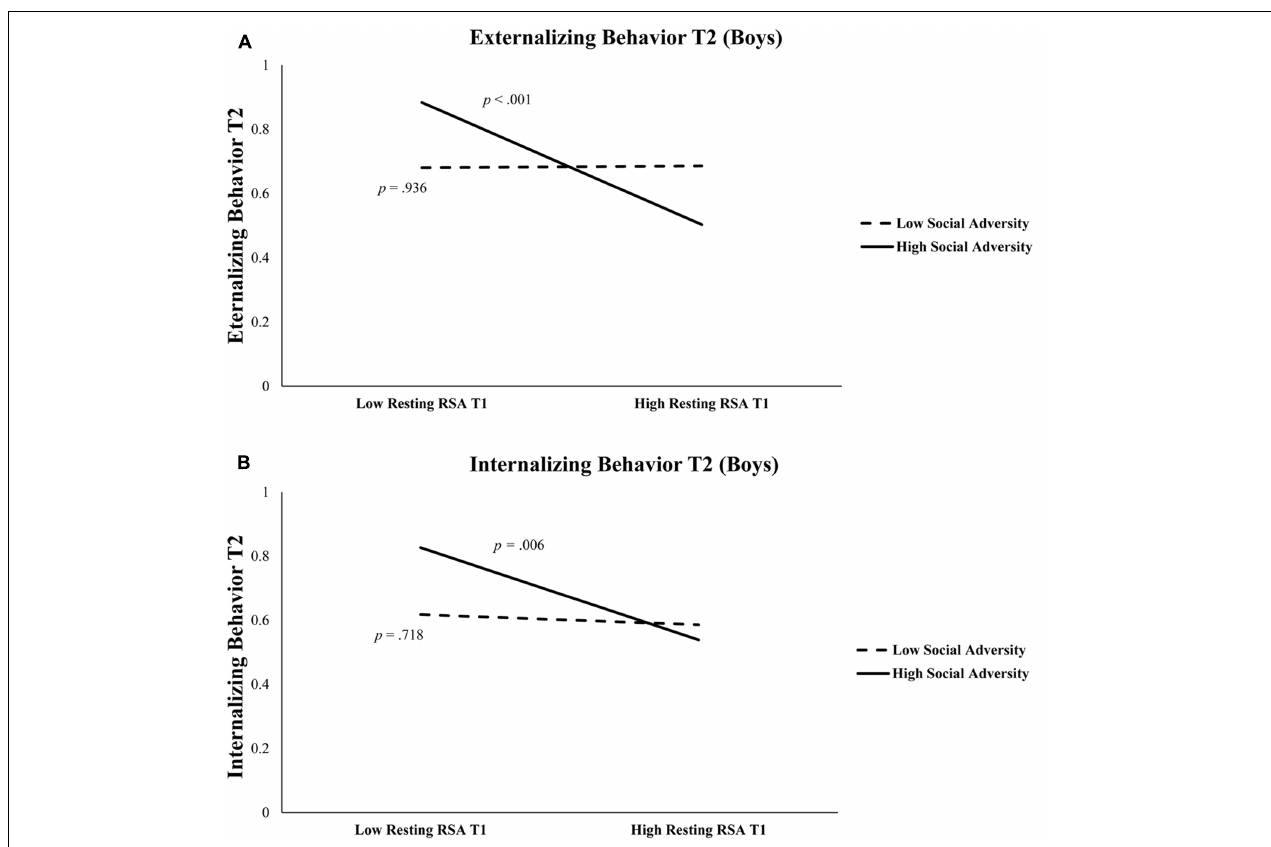
FIGURE 1 | (A) Externalizing behavior at Time 2 is predicted by resting RSA × social adversity at Time 1 in boys. High Social Adversity or Resting RSA (+1 SD ), Low Social Adversity or Resting RSA (–1 SD ). (B) Internalizing behavior at Time 2 is predicted by resting RSA and social adversity at Time 1 in boys. High Social Adversity or Resting RSA (+1 SD ), Low Social Adversity or Resting RSA (–1 SD